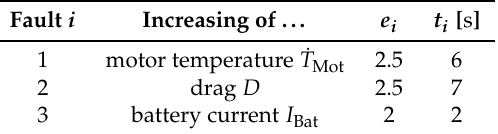
Table 1. Numerical values and occurrence times of the faults.